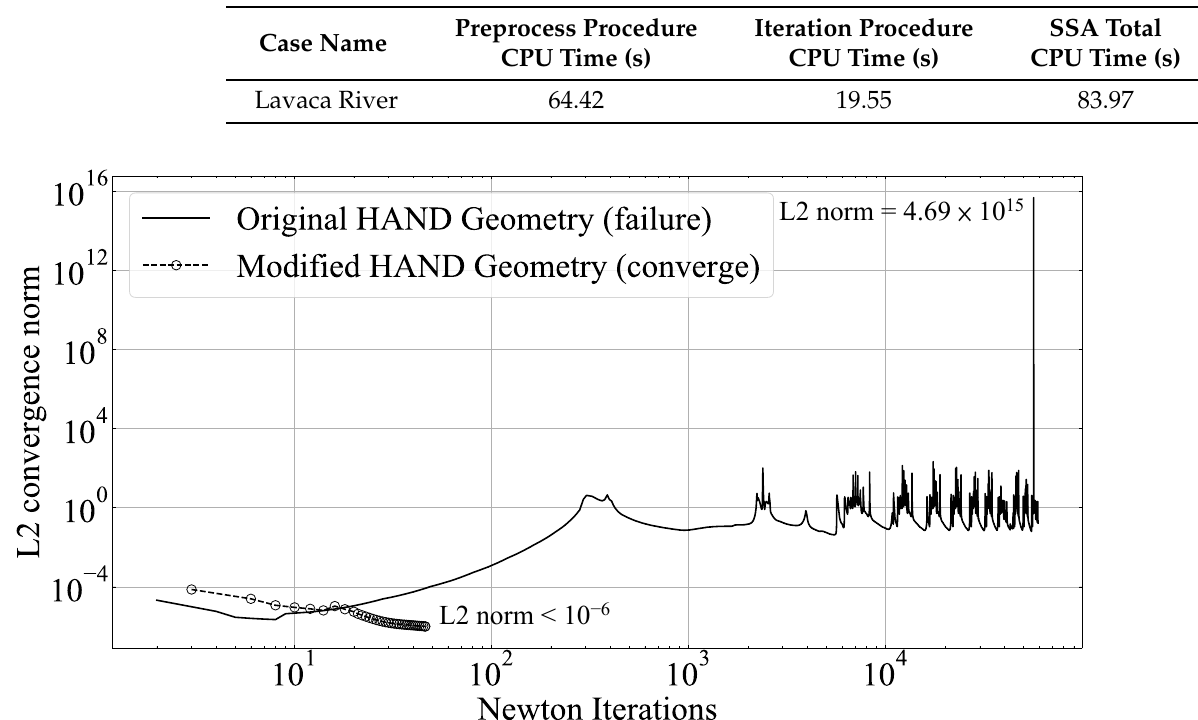
Figure 10. Comparison of the L2 norm for Newton iterations in the Lavaca River network simulation with SSM solver. The simulation with original geometry is shown in the star plot, and the modified geometry is shown in circle